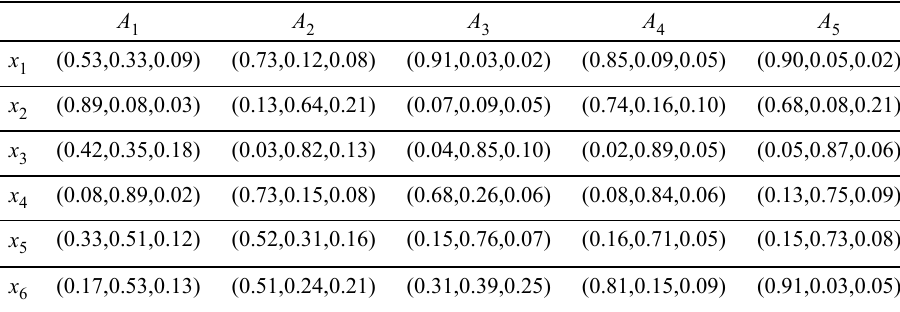
Table 1. The picture fuzzy decision